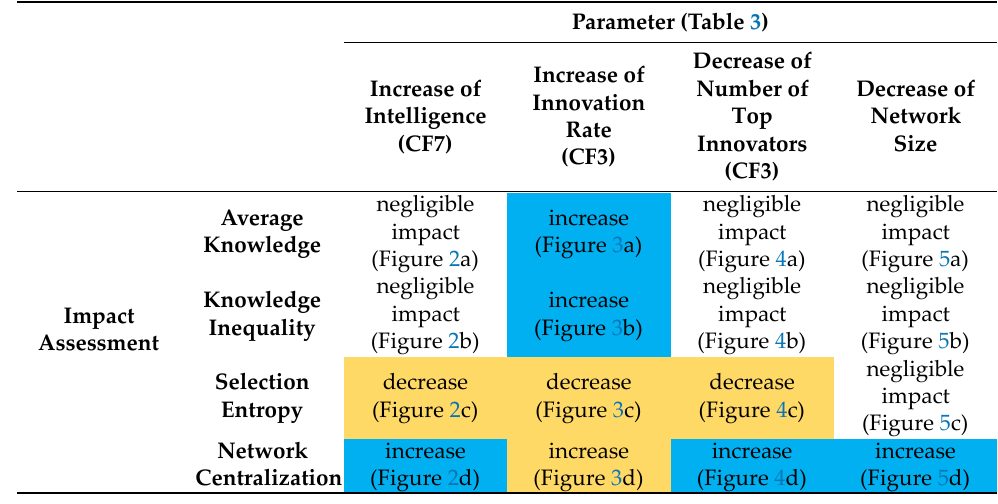
Table 4. Impact of